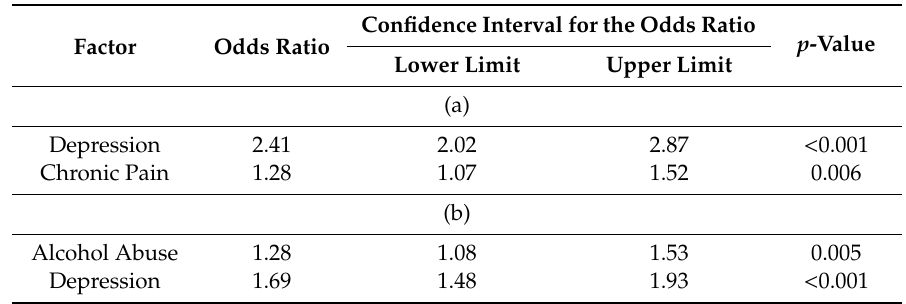
Table 3. (a) Odds ratios for the association of alcohol abuse with chronic pain and depression; (b) Odds ratios for the association of chronic pain with alcohol abuse and depression. Confidence Interval for the Odds Ratio Factor Odds Ratio